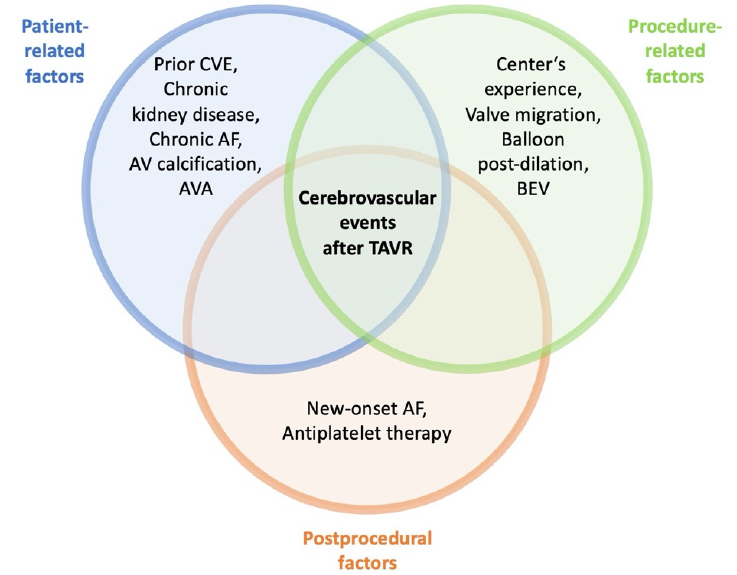
Figure 1. Previously identified factors associated with cerebrovascular events after TAVR with three overlapping categories: patient-related factors, procedure-related factors, and post-procedural factors. AF = atrial fibrillation; AV = aortic valve; AVA = aortic valve area; BEV = balloon-expandable valve; TAVR = transcatheter aortic valve replacement; CVE = cerebrovascular event.